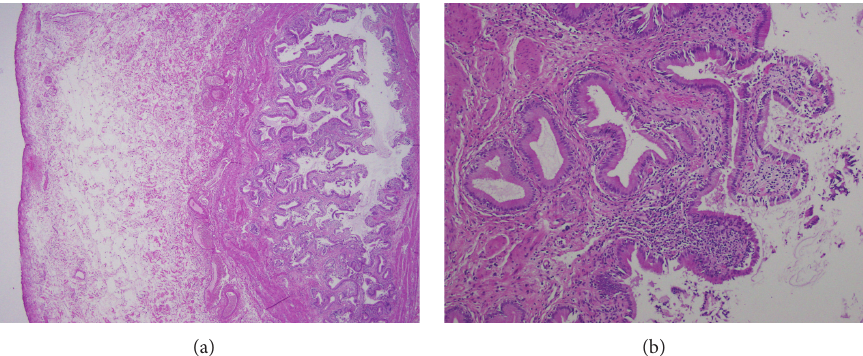
Figure2:(a)Histologyofgallbladder:lowmagnification( × 4);(b)histologyofgallbladder:highmagnificationshowingchronicinflammatory cell infiltrate ( × 40).